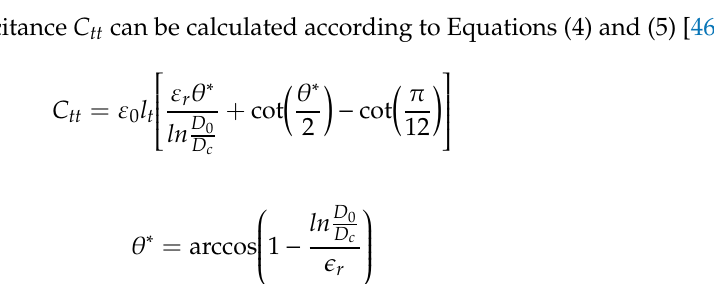
Figure 6. Stray capacitance network model of the electromagnetic coil with m layers and n turns per layer.